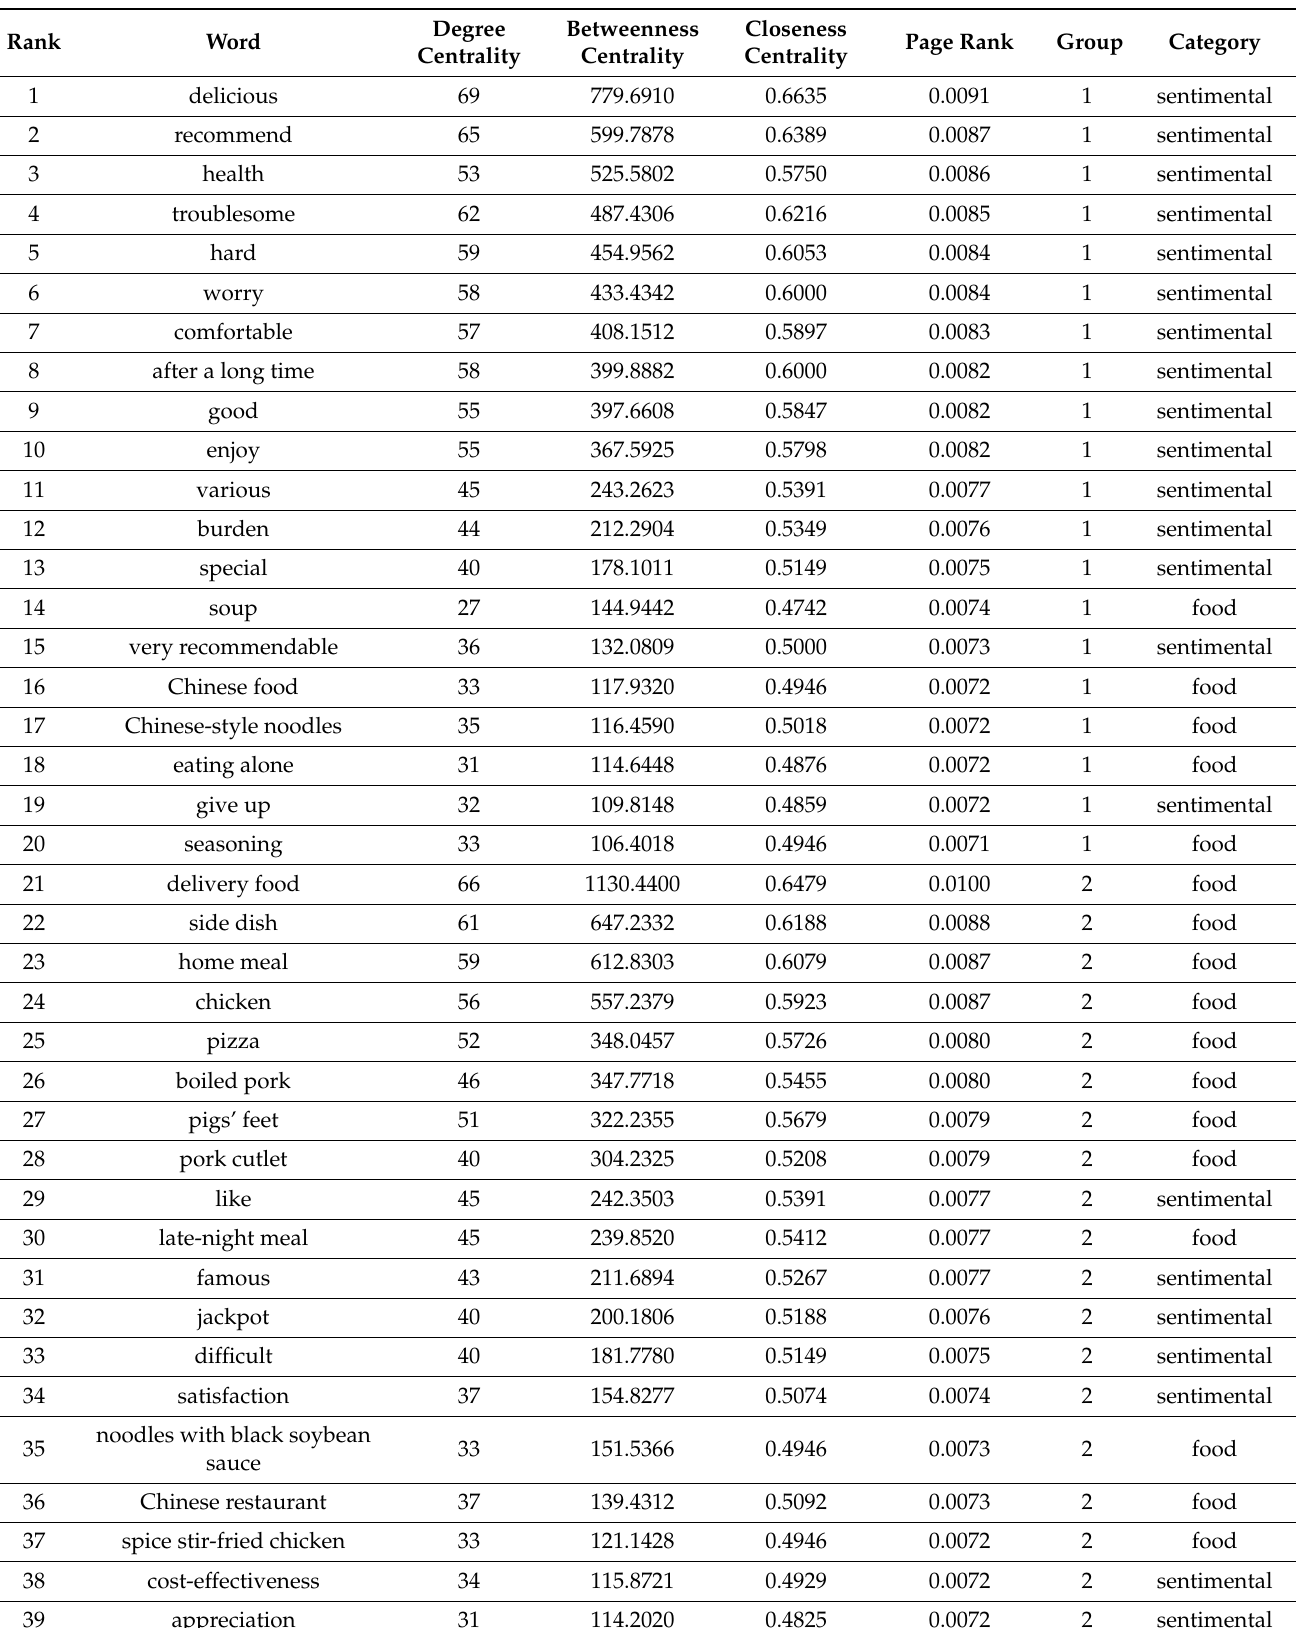
Table 5. Sentimental network index of food delivery